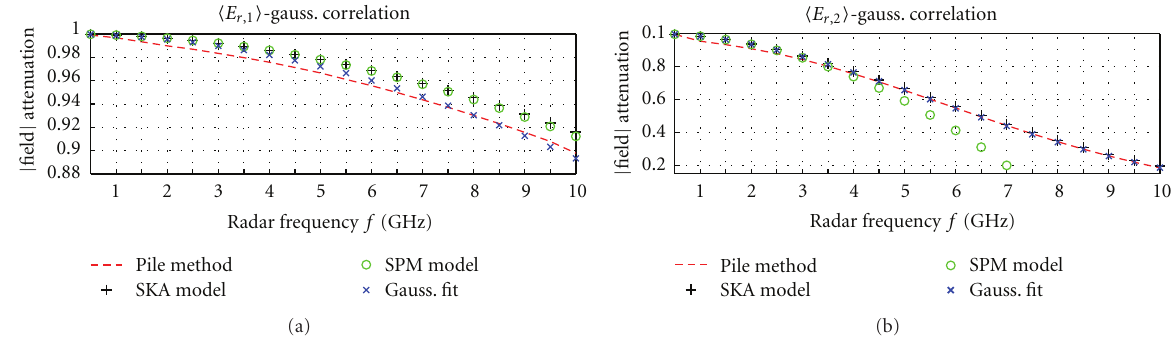
Figure 4: Frequency behavior of the amplitude attenuation of the coherent scattered fields (cid:2) E r ,1 (cid:3) and (cid:2) E r ,2 (cid:3) (V polarization) in the frequency band f ∈ [0 . 5; 10 . 0]GHz, comparatively to the flat case. Results from the PILE code and comparison with the SKA and SPM2 asymptotic models for Gaussian surfaces. The upper and lower correlation lengths are L c A = 6 . 4mm and L c B = 15 . 0mm, respectively.